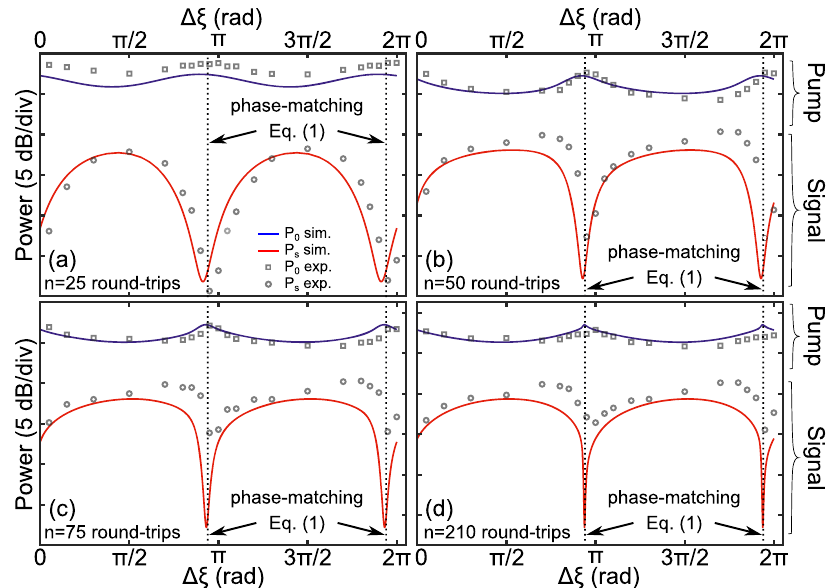
Fig. 5 Intra-cavity power evolution. a − d Intra-cavity signal and pump powers versus Δ ξ (relative input phase) at n = 25, 50, 75, and 210 round-trips, respectively. Gray circles and squares stand for the measured signal and pump power, respectively. Solid red and blue curves correspond to numerical simulations of the Lugiato − Lefever equation (Eq. 4).